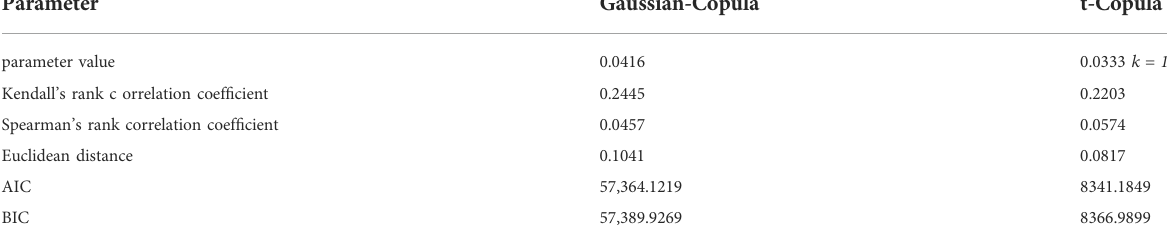
TABLE 6 Estimated values of relevant parameters of the Copula